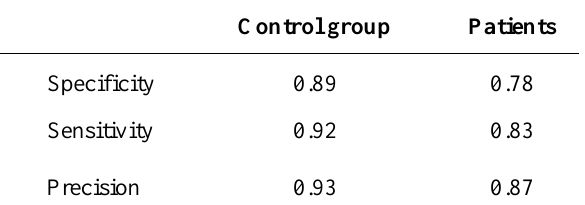
Table 1: Results for the prediction of hazardous event perception from the pupil